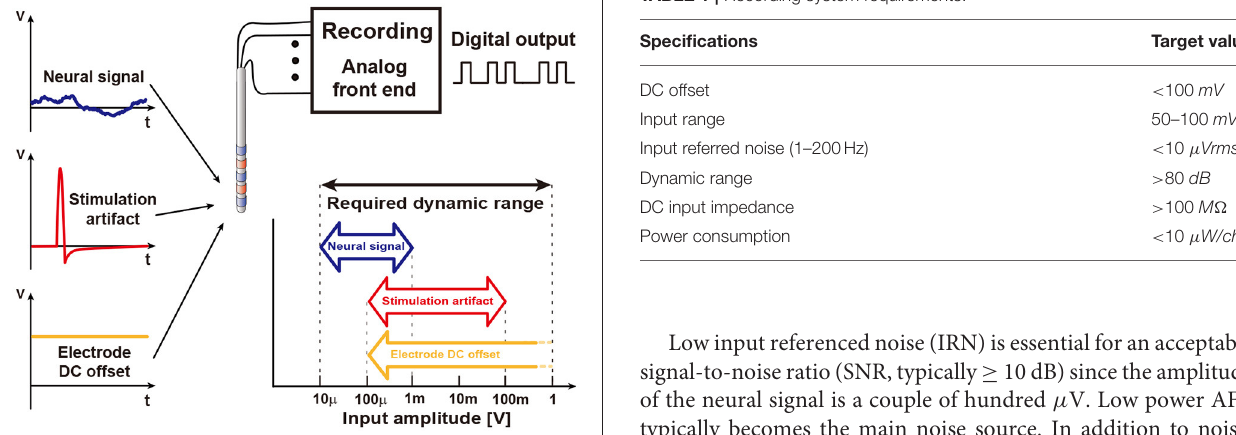
TABLE 1 | Recording system